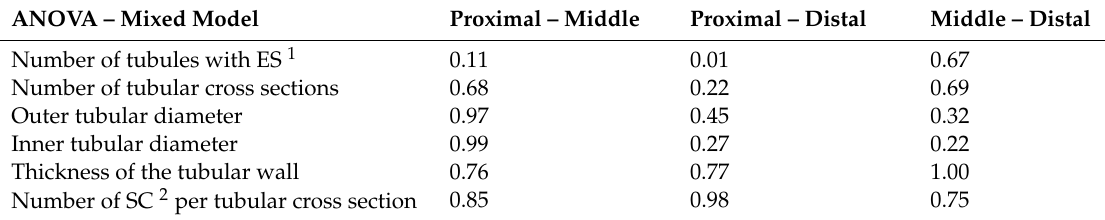
Table 2. Test results (i.e., p- values) of the ANOVA (mixed model) comparing the three tissue sample locations among each other measured in haematoxylin-eosin (HE) staining. P-values were compared to the Bonferroni-adjusted significance level of alpha Bonf = 0.0083, like in Table 4.